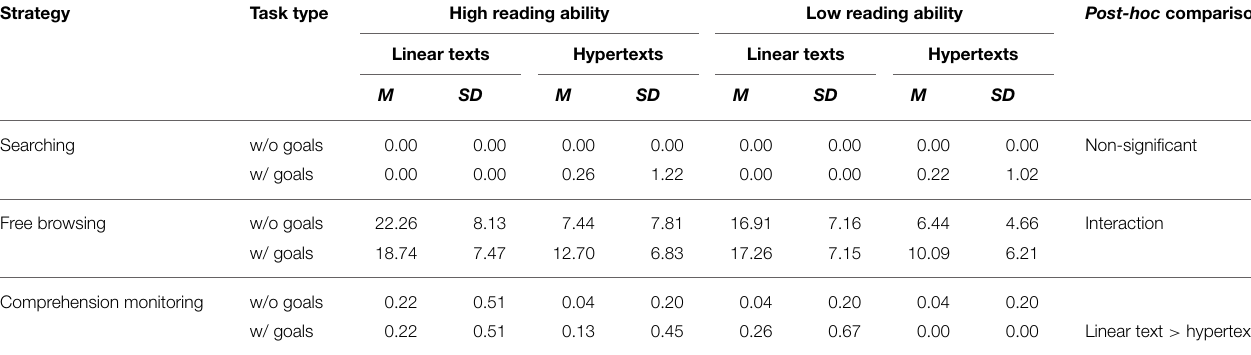
TABLE 5 | Mean and SD values of the frequencies of using three online reading strategies. Strategy